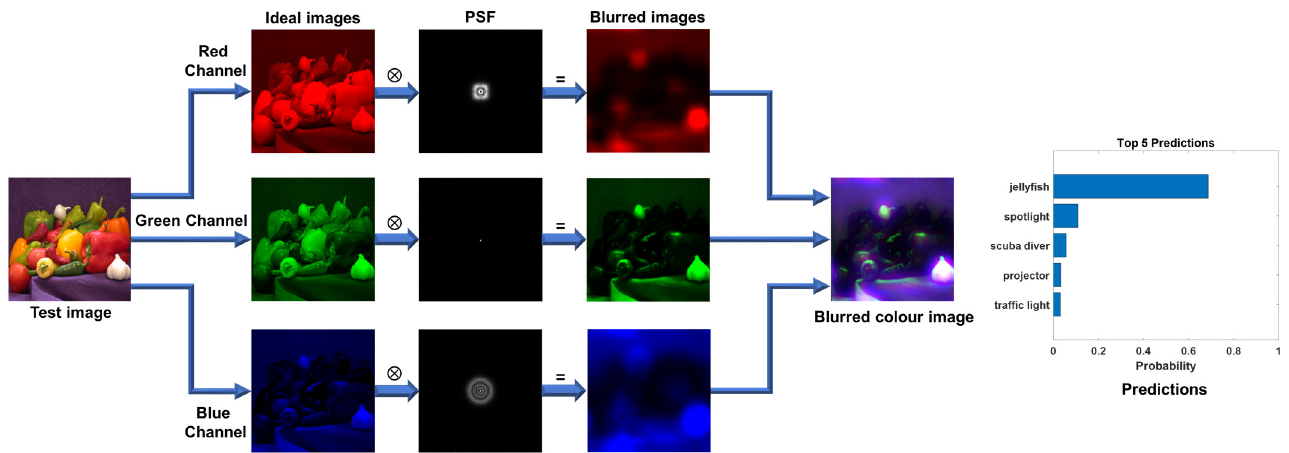
Figure 9. Method of applying chromatic aberrations to a color image and classification of the resulting blurred image using